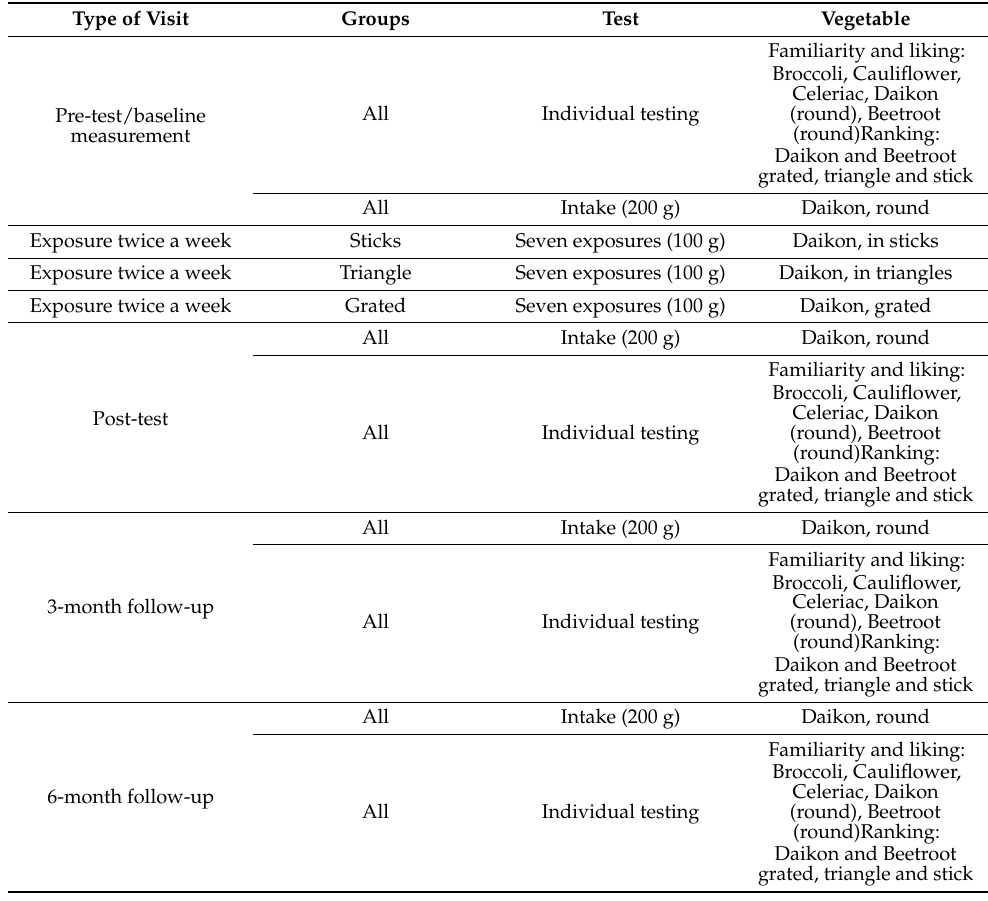
Table 1. Overview of the content of the different visit